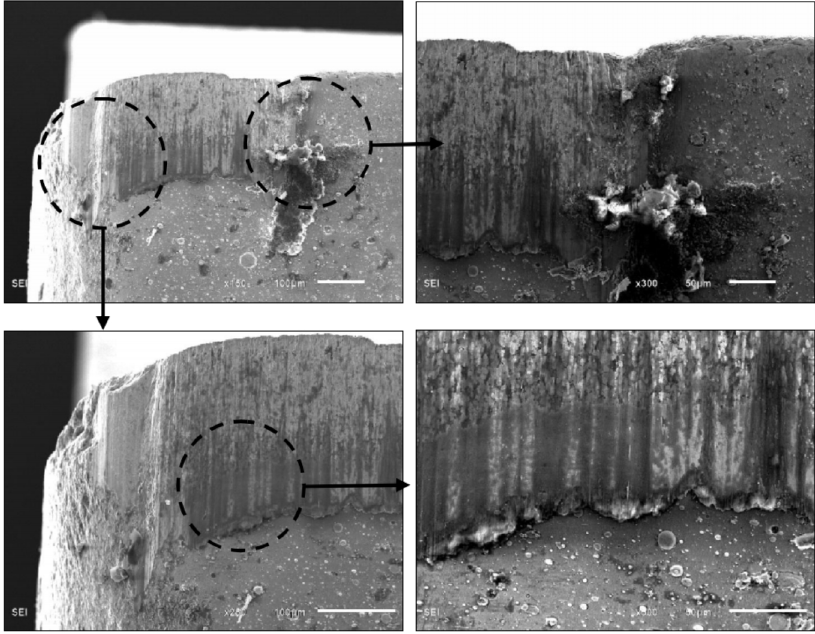
Figure 14. Micrographs of worn flank face of SZT ( v = 120 m/min, a p = 0.20 mm, f = 0.10 mm/r, L = 3600 m).